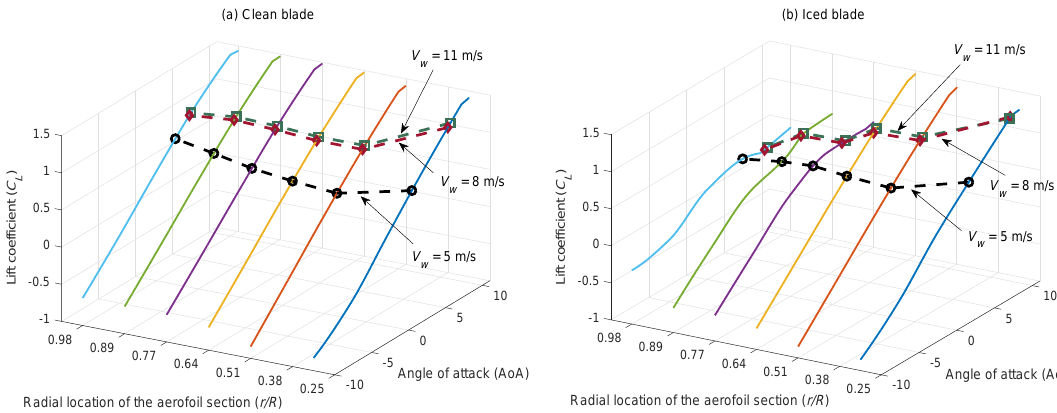
Figure 14. Steady-state operating points of different aerofoil sections of the clean and iced turbine